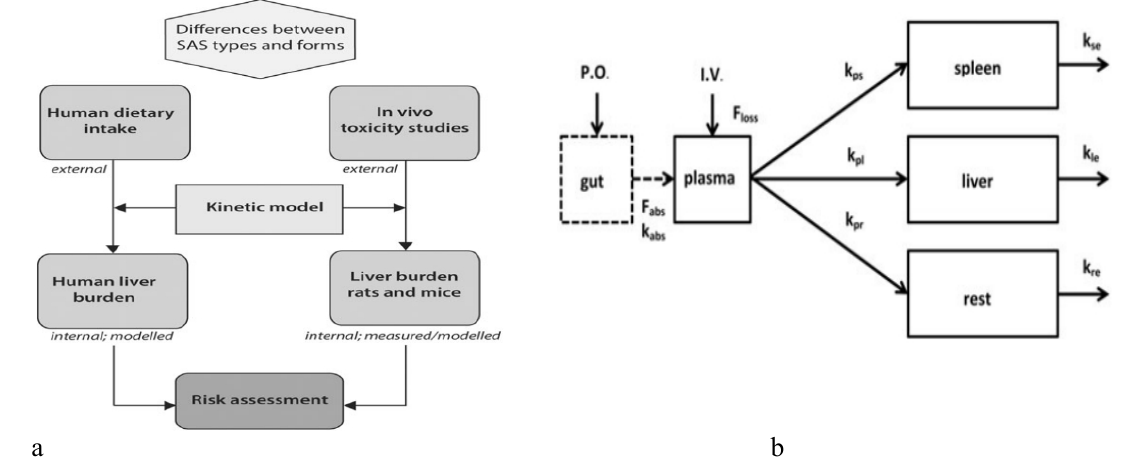
Fig. 9. Scheme of the risk assessment process for kinetic modeling and its elements (a), the kinetic model scheme